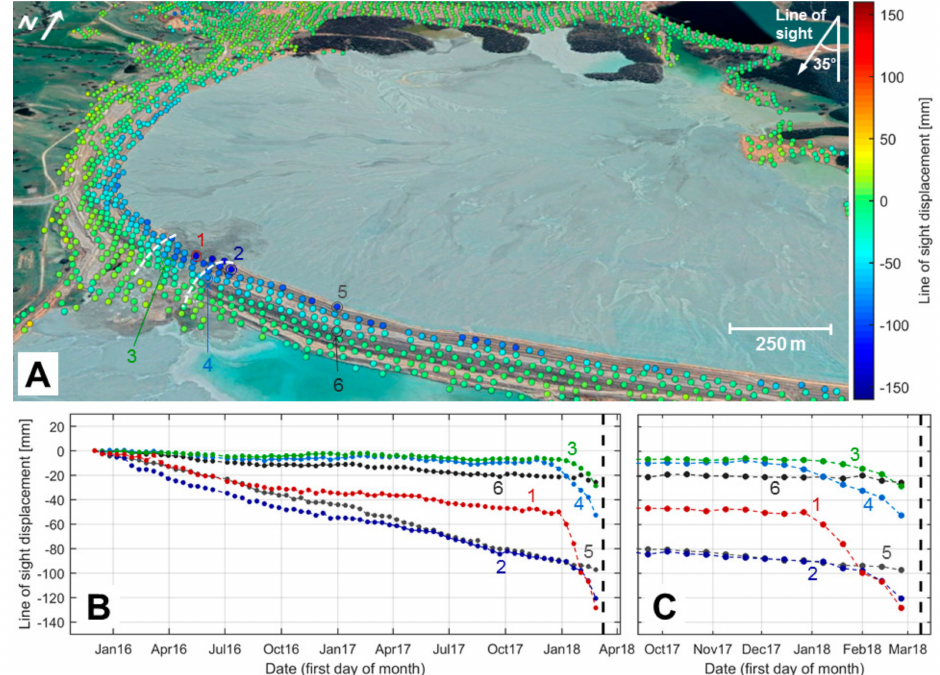
Figure 8. Detection of precursory movement before failure of a tailings dam wall at the Cadia gold mine, New South Wales, derived from the InSAR analysis of Sentinel-1 between 201502 and 20180225. ( A ) Cumulative LoS displacements measured along the dam wall overlain on a background Google Earth image from 20180510. The white lines approximately indicate the failure zone as inferred from optical imagery after the collapse. ( B ) Time-series of displacement at points 1–4 labelled in A. Time of failure is shown by the dashed black line. ( C ) Zoomed in section of the time-series in